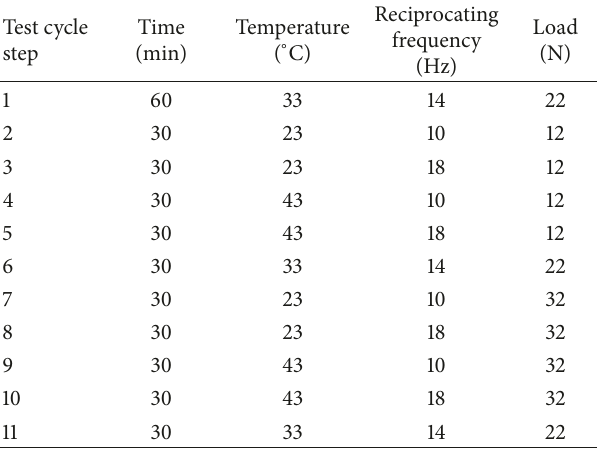
Table 1: Overview of input parameters of test cycle